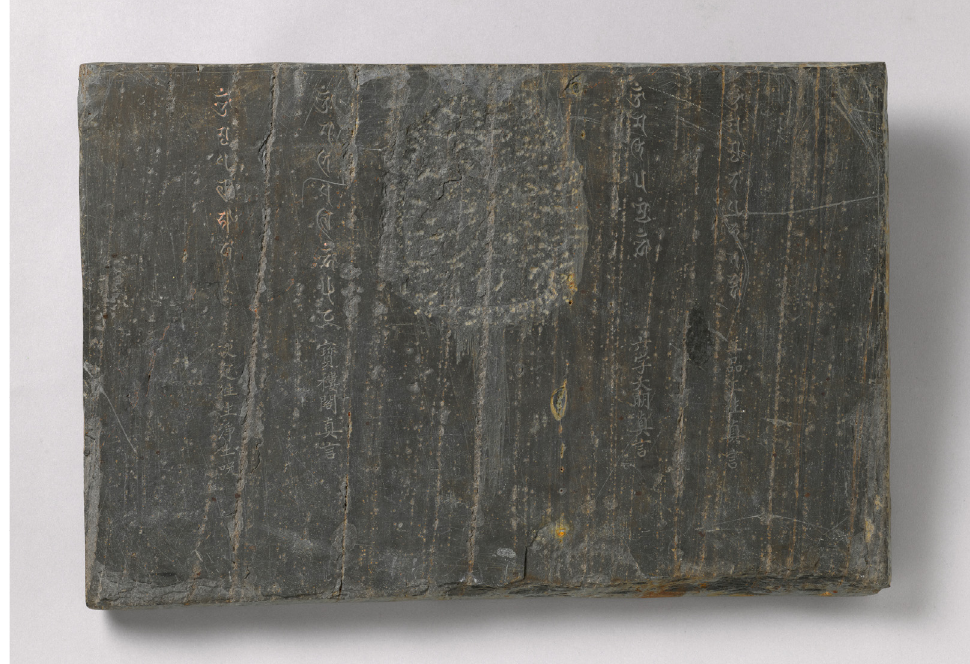
Figure 9. Sanskrit incantations on the back of Yang T’aekch’un’s tomb epitaph. Koryŏ dynasty, dated 1254. 57.5 × 37.5 × 4.5 cm. National Museum of Korea.